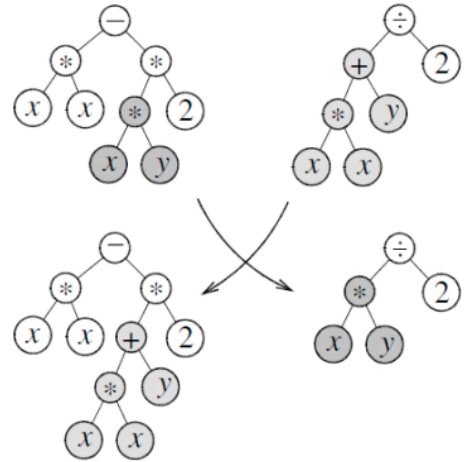
Figure 4. Genetic programming (GP) operation.